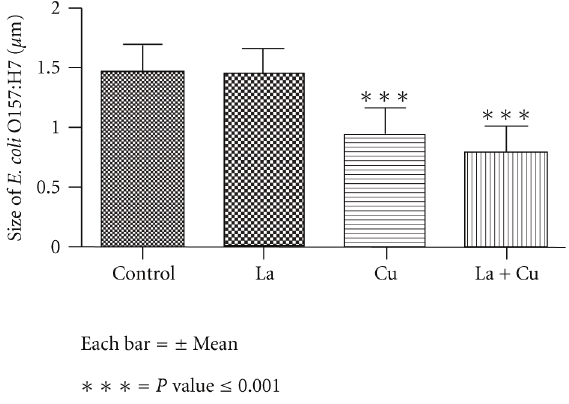
Figure 3: Histogram showing size ( µ m) of E. coli O157:H7 after treated with copper and lactic